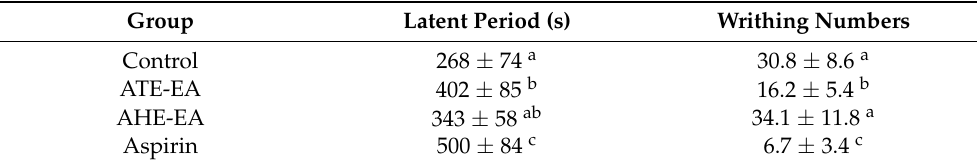
Table 3. Effect of ATE-EA and AHE-EA on the acetic acid writhing response in acetic acid-treated mice. The latent period and umber of writhes was counted for 30 min after oxytocin administration.